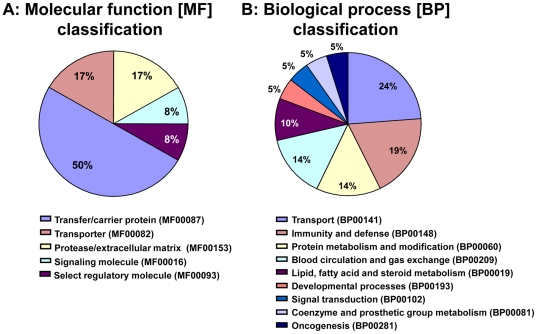
Pathway analysis results of the cord blood proteome dys-regulated in cord blood of premature newborns with culture confirmed EONS.Identities differentially expressed at least 1.5-fold were distributed by molecular function (A) and biological process (B) using PANTHER system.